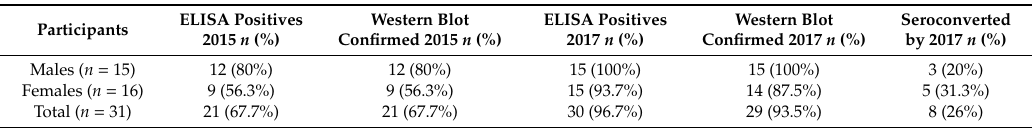
Table 3. Serological status of “dual participants”: schoolchildren who participated in both 2015 and 2017.